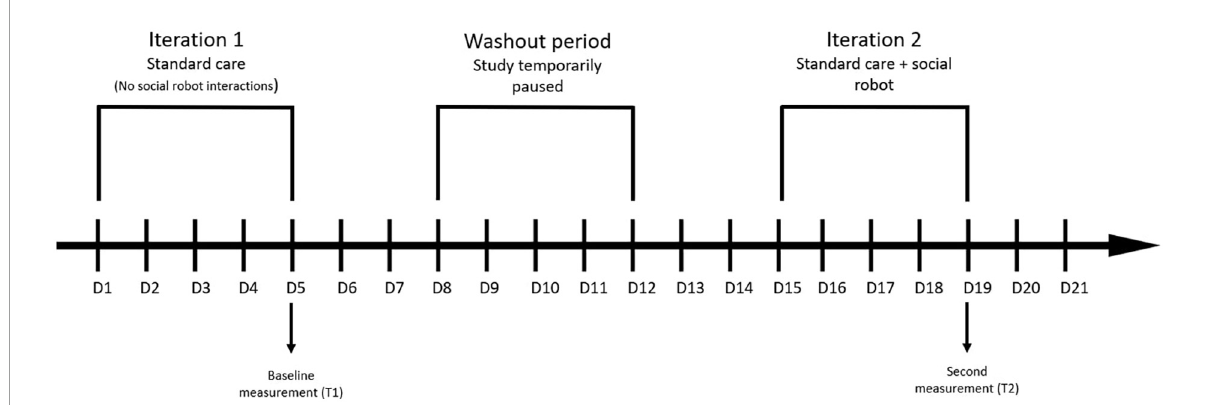
FIGURE2 Study design: staff. This figure depicts only the first two measurements. The same protocol will be carried out at the 1-year mark and right before the end of the study (approximately 2 years after the